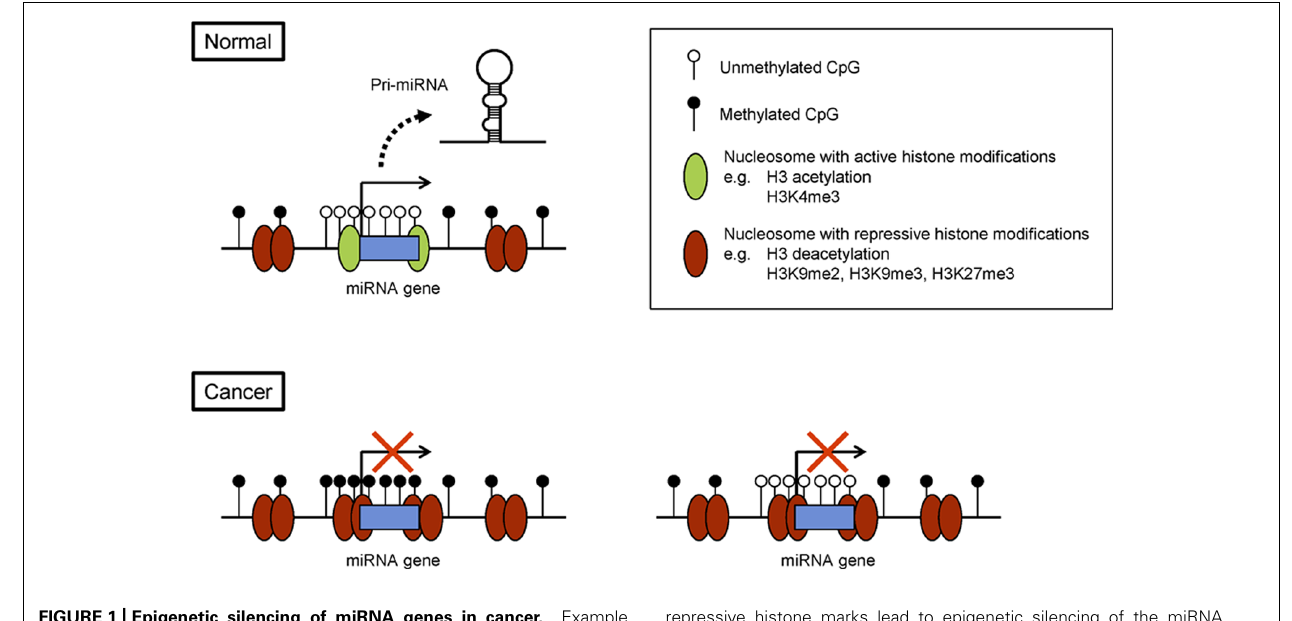
FIGURE 1 | Epigenetic silencing of miRNA genes in cancer. Example of a miRNA gene with its CpG island. In normal cells, the CpG island is unmethylated, and the chromatin is associated with active histone modifications. In cancer cells, CpG island hypermethylation and